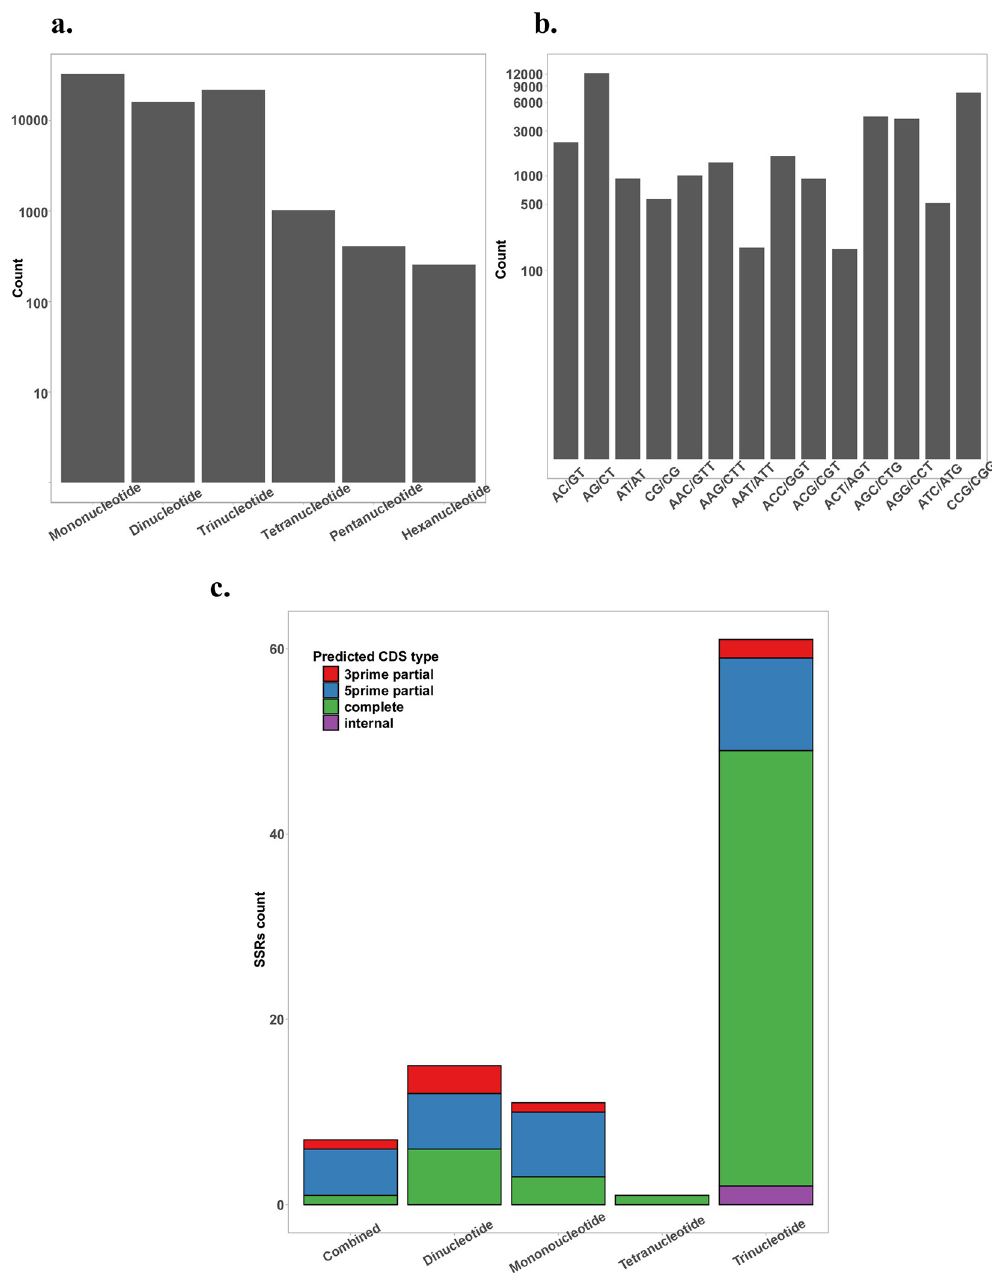
Fig 7. SSRs identified in P . australis transcriptome assembly “cd_hit”. a. Distribution of all SSRs categories in P . australis transcriptome; b. Distribution of all subcategories of dinucleotide and trinucleotide in P . australis transcriptome; c. Distribution of CDS-SSRs in P . australis transcriptome. It is based on the number of each category of SSRs, and each category is stacked by the type of candidate coding region. Combined is the SSRs with more than one repeats in the closed location of the